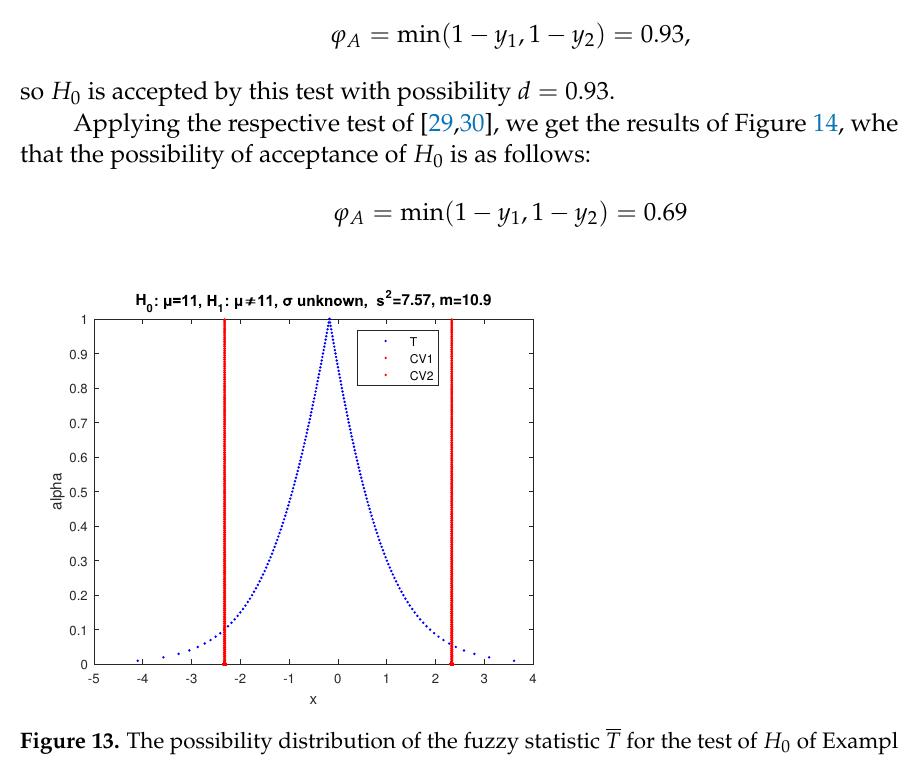
Figure 13. The possibility distribution of the fuzzy statistic T for the test of H 0 of Example